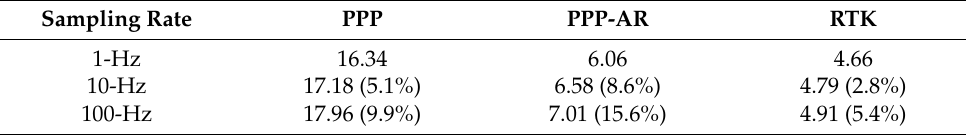
Table 3. RMSE of 100-, 10-, and 1-Hz displacement time series derived with PPP, PPP-AR, and RTK techniques (in mm). The values in the brackets are the percentage increases compared to the 1-Hz standard